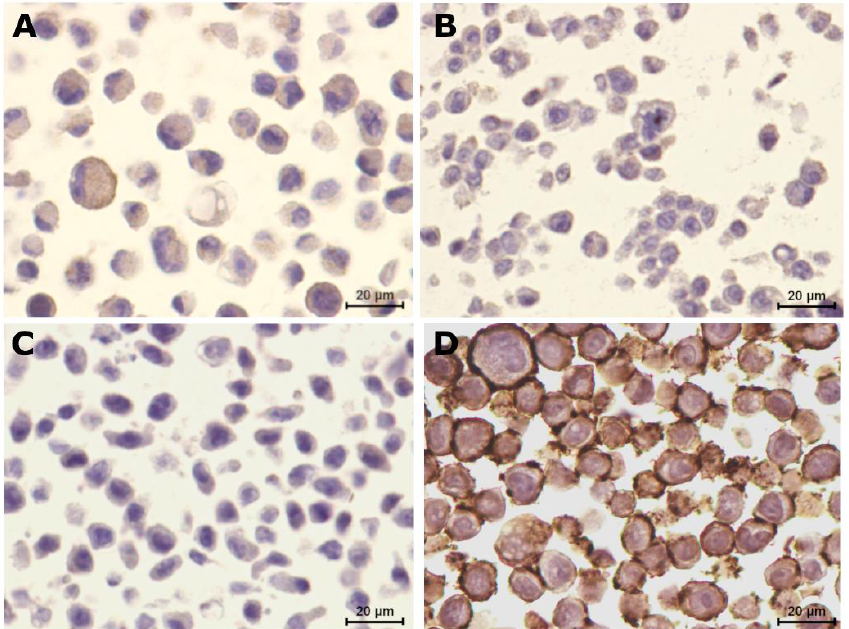
Figure 2. Feline mammary carcinoma cell lines presented different HER2 expressions. ( A ) CAT-MT cell line was classified as HER2-positive (HER2 2+ score). ( B ) FMCm was classified with 1+ score, being considered slightly positive for HER2 expression. ( C ) FMCp cell line presented no HER2 signal (HER2-negative). ( D ) The human SKBR-3 cell line was classified as a HER2-overexpressing cell line (3+ score). 400× magnification.